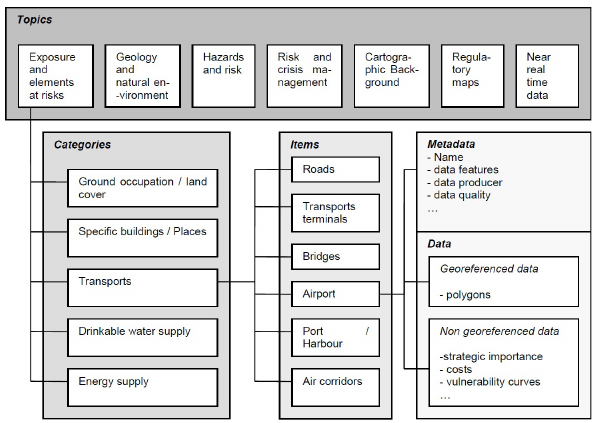
Figure 5. Extract of the taxonomy (i.e. controlled vocabulary organised in a hierarchical form) describing the content of the hazard and risk geographical database.